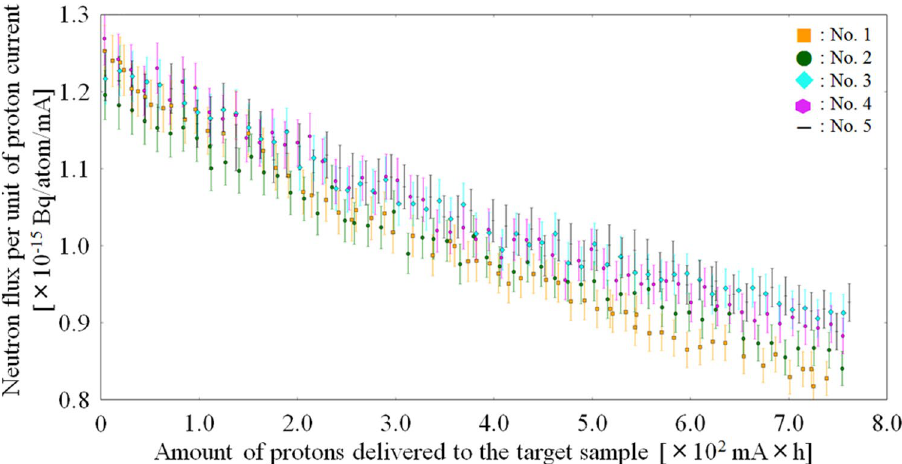
Figure 2. Measured neutron flux per unit of proton current in each target sample. The saturated radioactivity of 198 Au was used as a substitute for the neutron